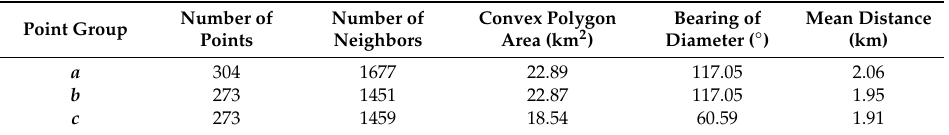
Table 2. Statistical data of point